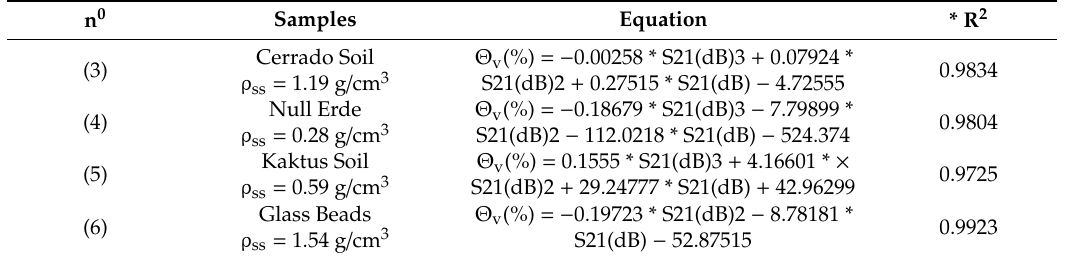
Table 3. Table with four equations used to modeling the calibration to each